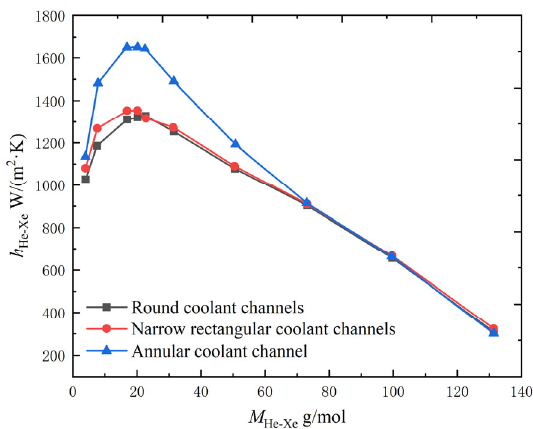
Figure 18. Variation of convective heat transfer coefficient with channel shape in the coolant channel for helium–xenon gas mixture [29]. Table 9. Comparison of the equivalent diameters (d e ) of the three coolant channels [29].